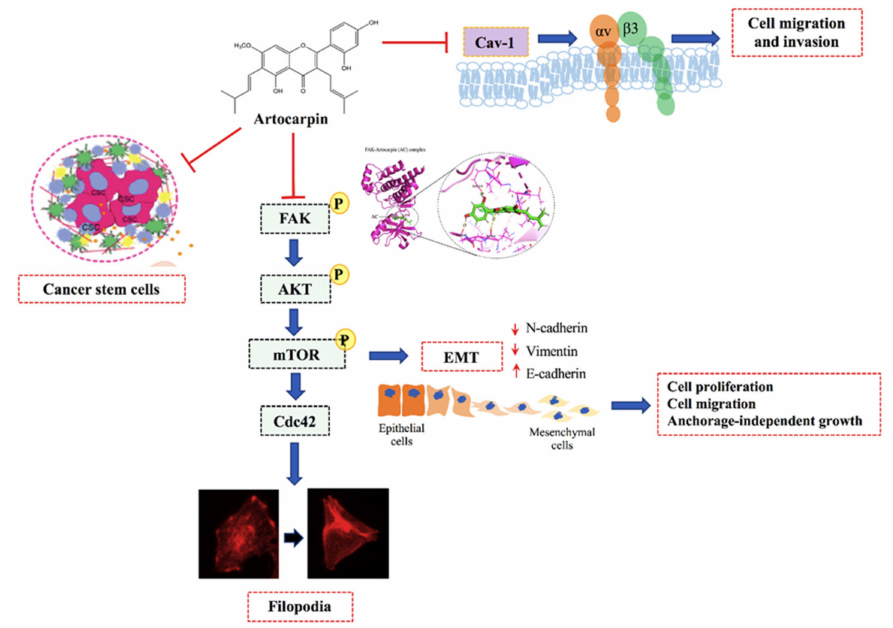
Figure 8. Schematic mechanism of artocarpin suppressing EMT and CSC in lung cancer